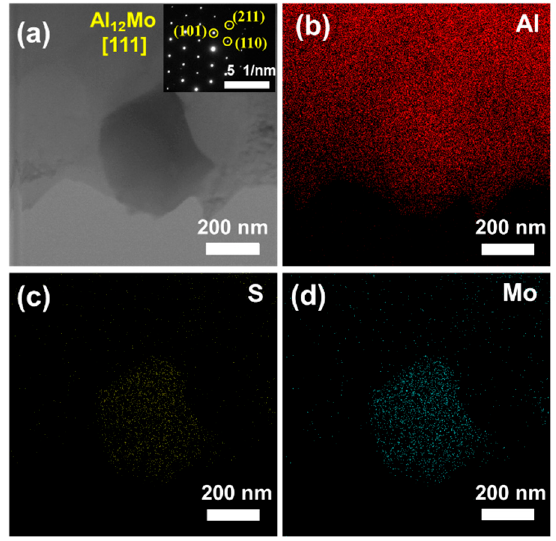
Figure 9. TEM images of the Al 12 Mo particles in 1.5 wt.% FLM/Al composite sintered at 630 °C. ( a ) Morphology of Al 12 Mo particles, and the inset is the SAED of part of ( a ), ( b – d ) element mapping of Al, S, and Mo.